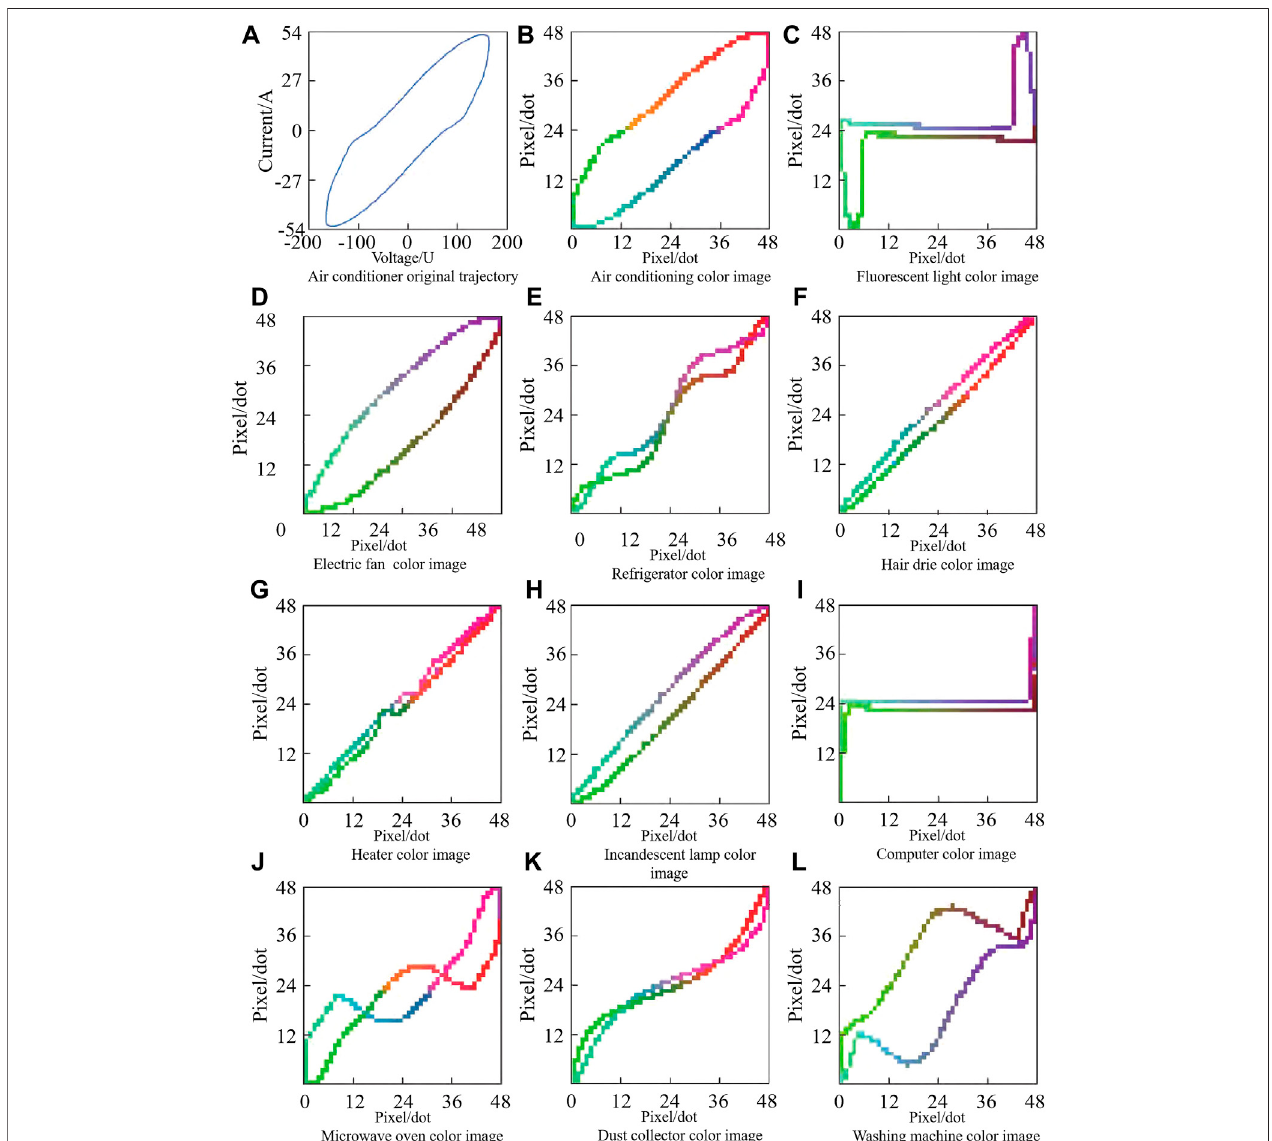
FIGURE 3 | Color V-I images of various electrical